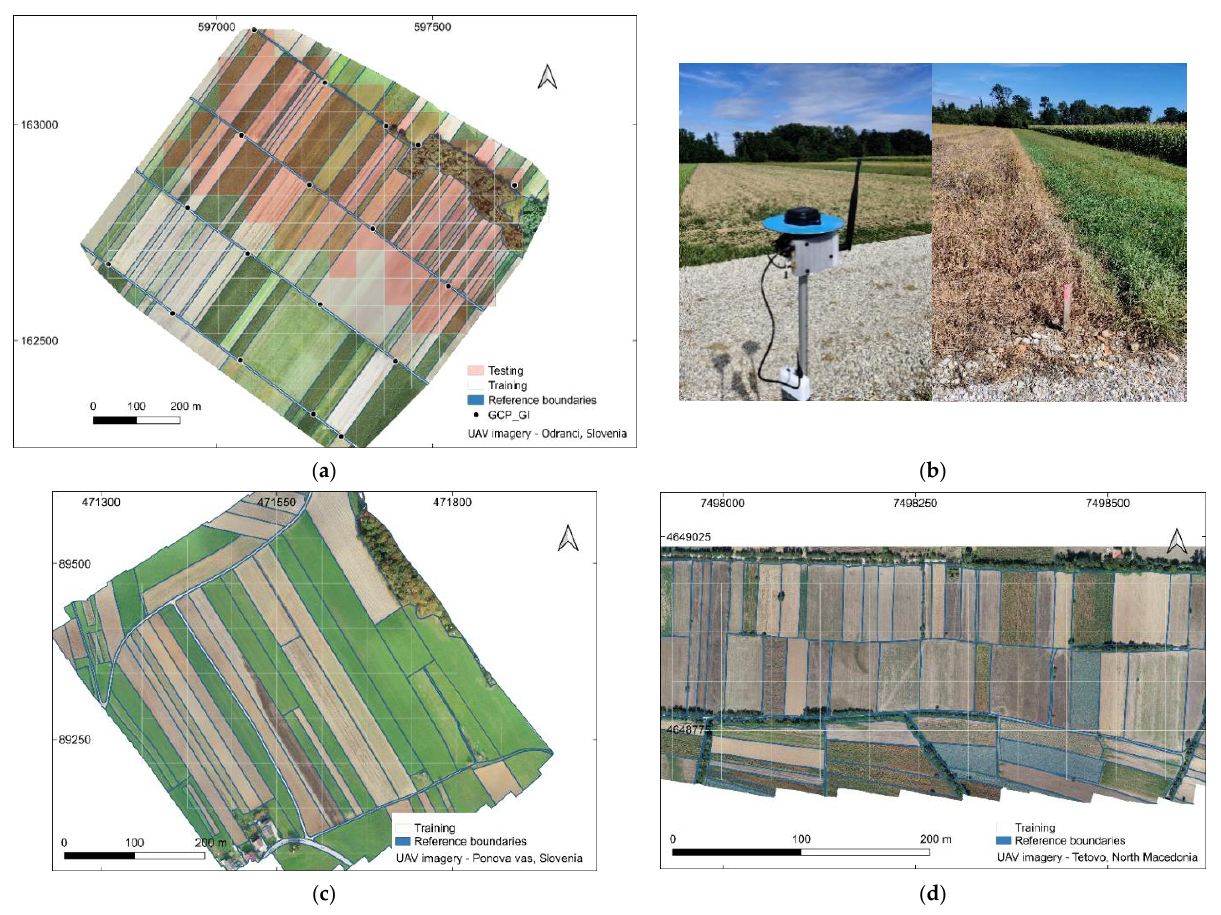
Figure 1. ( a ) UAV imagery of 0.25 ground sample distance (GSD) for Odranci–Slovenia, divided into areas for training and testing; ( b ) low-cost instrument ZED-F9P and example of visible cadastral boundaries. ( c ) UAV imagery of 0.25 (GSD) for Ponova vas—Slovenia, used for training; ( d ) UAV imagery of 0.25 (GSD) for Tetovo—North Macedonia, used for training.